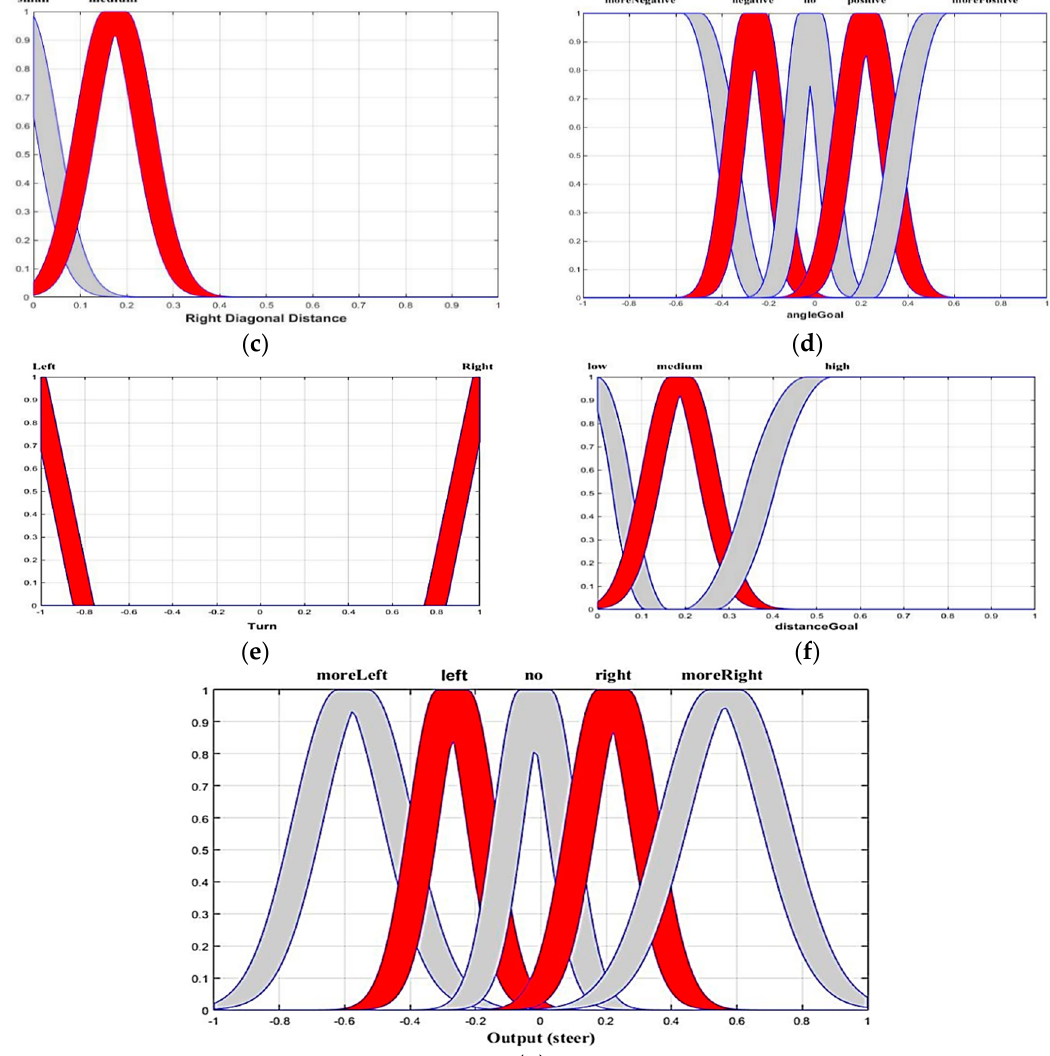
Figure 7. The membership functions (inputs: ( a – f ), output: ( g )).